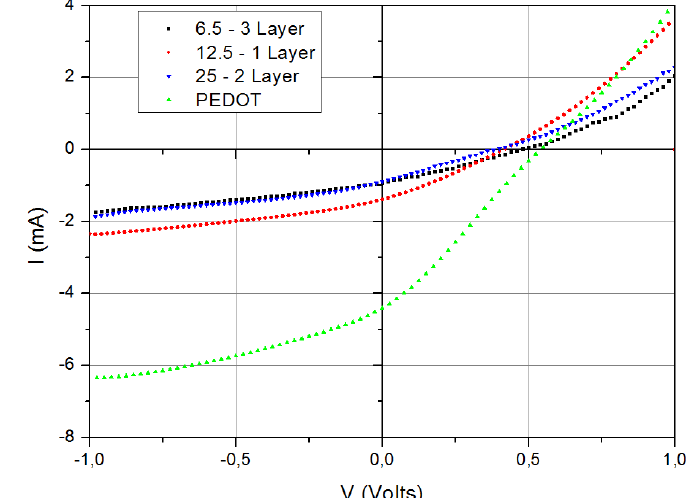
Figure 4. IV curves on small devices under 1,000 W/m 2 illumination, using several VTIP concentrations, and a similar cell with